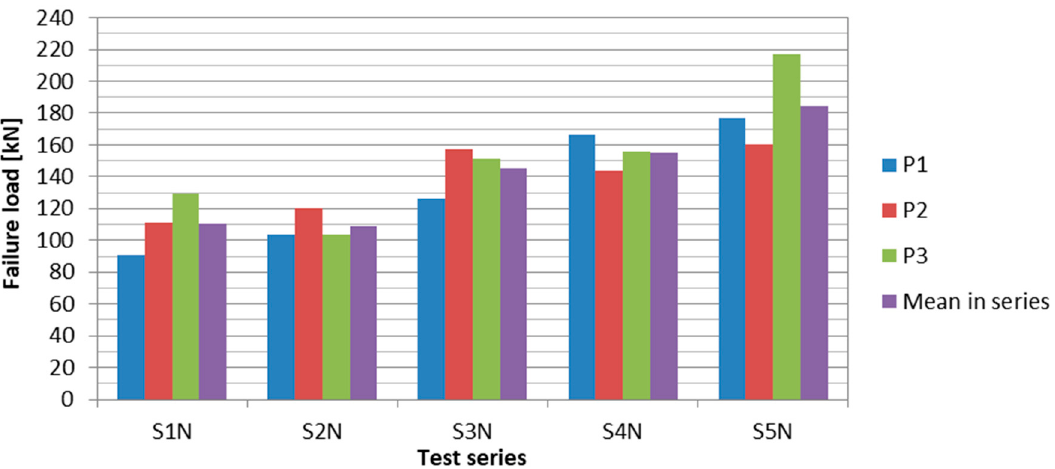
Figure 24. Increasing of failure loads in subsequent test series.